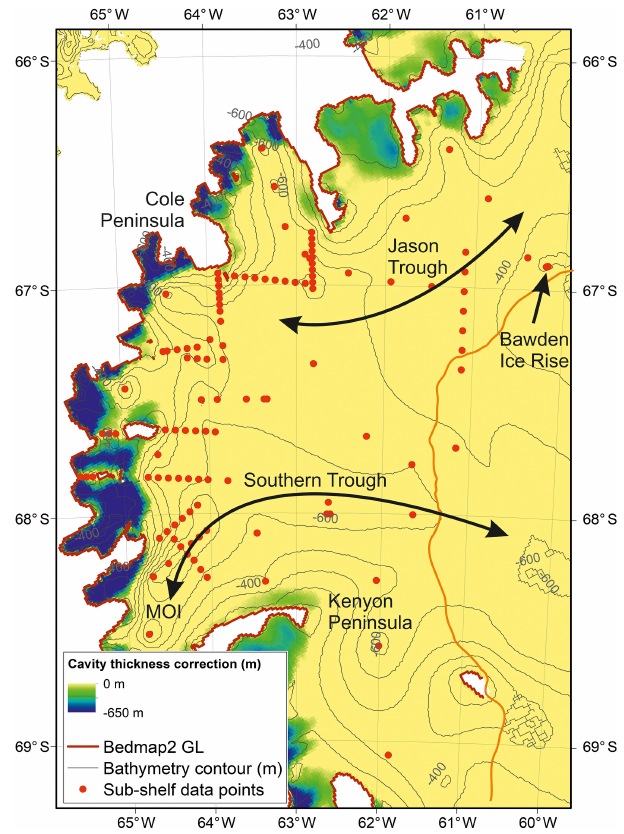
Figure 4. Difference between the grid corrected for the Bedmap2 ice draft mismatch and the original natural neighbour interpolation grid in metres, highlighting areas where the cavity has been forced to